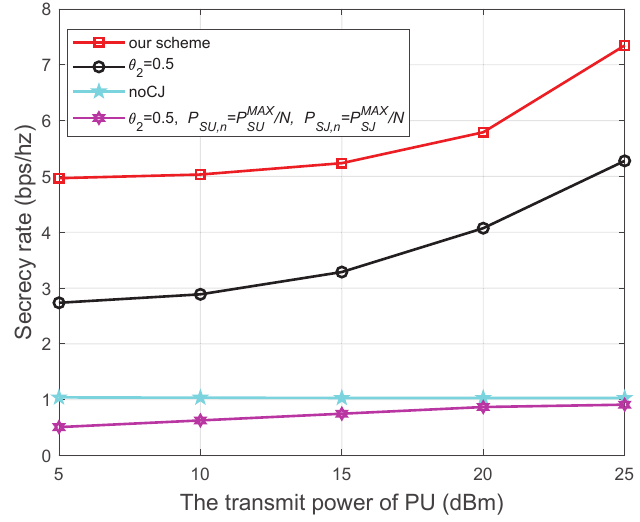
Figure 7. The secrecy rate versus the transmit power of PU.